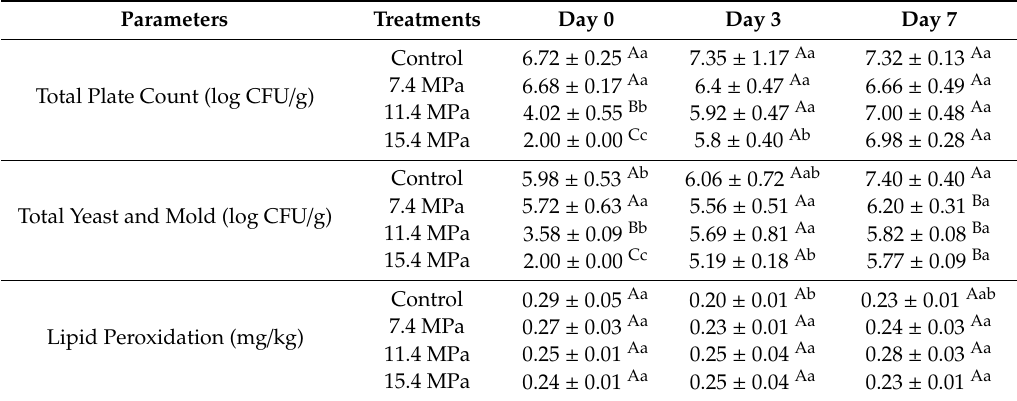
Table 1. E ff ects of three levels (7.4, 11.4 and 15.4 MPa) of SC-CO 2 at 31 ◦ C for 10 min on the total plate count, total yeast and mold count, and lipid peroxidation of raw chicken meat stored at 4 ± 1 ◦ C for seven